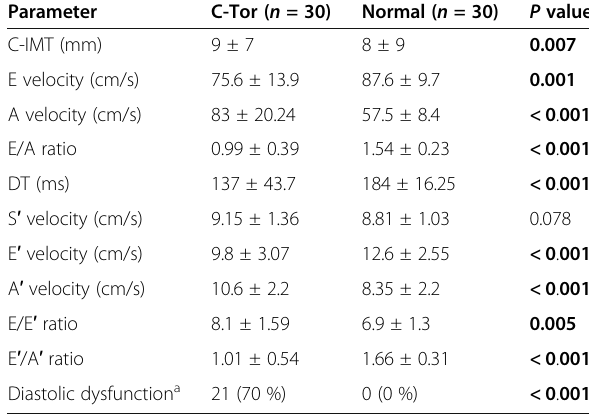
Table 3 Echocardiographic and Doppler parameters of the patients with and without coronary